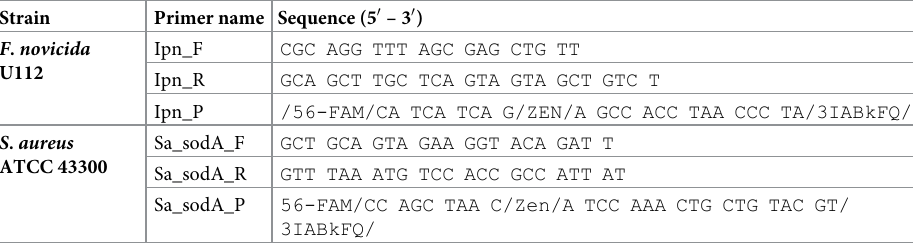
Table 1. Primers and probes used for DNA stability